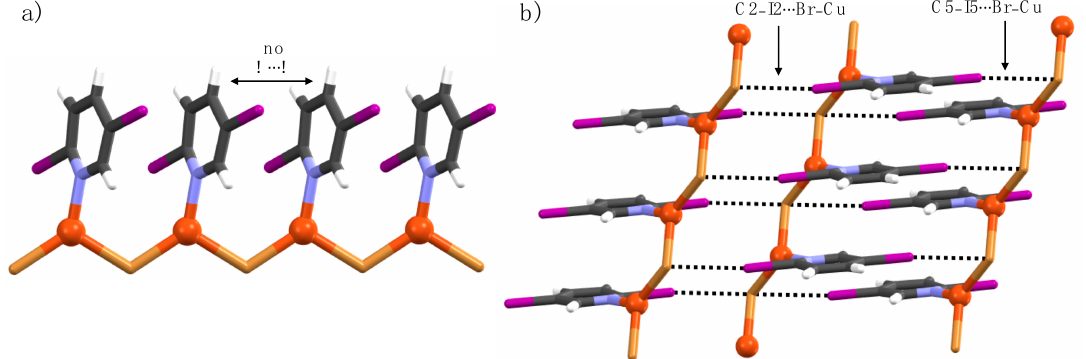
Figure 5. ( a ) X-Ray crystal Structure of 4b , and ( b ) section of 1-D polymer chains in crystal packing displaying halogen bonds (black dotted lines).